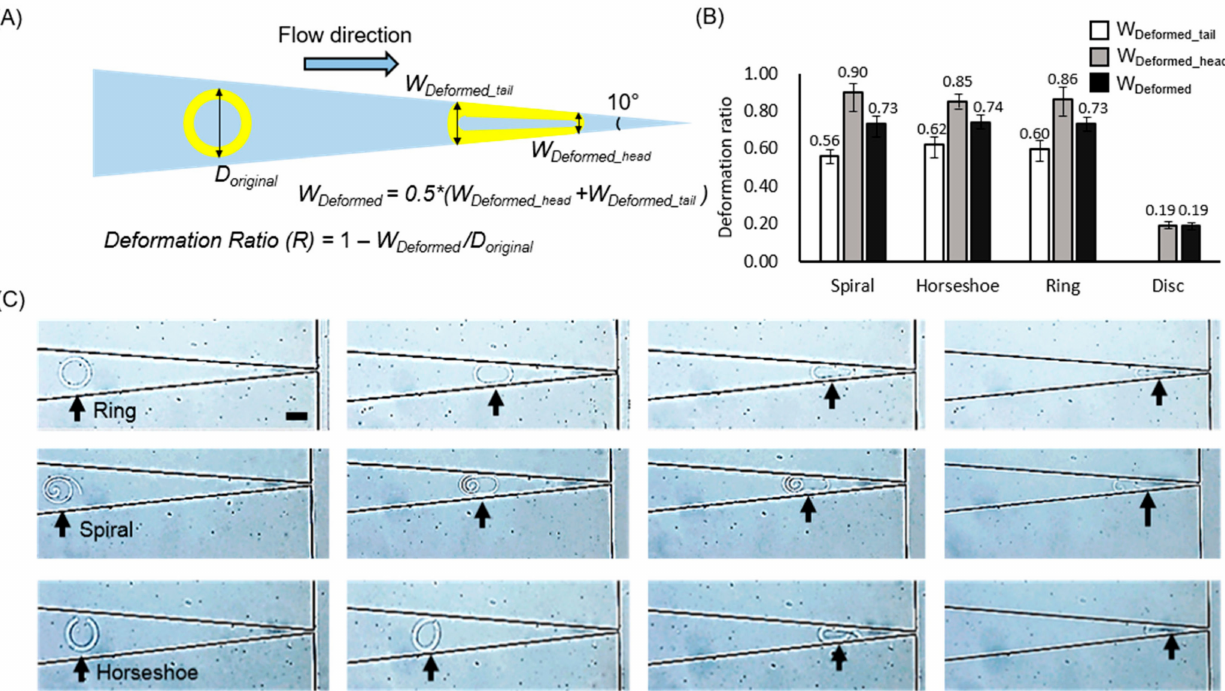
Figure 3. In-situ measurements of the deformability of microparticles. ( A ) Schematic illustration of the deformation ratio ( R = 1 − W deformed /D original ). D original : diameter of the microparticle, W deformed : average width at the head (W deformed_head ) and tail (W deformed_tail ) of the microparticle, where the tapered angle at the outlet is 10 ◦ . ( B ) Measured deformation ratio of four designs: spiral, horseshoe, and ring ( V * = 0.5), and discotic microparticles ( V * = 1). The error bars represent the standard deviations ( n = 10). ( C ) Optical images of each microparticle to show their deformability in the microchannel. (scale bar: 100 µ